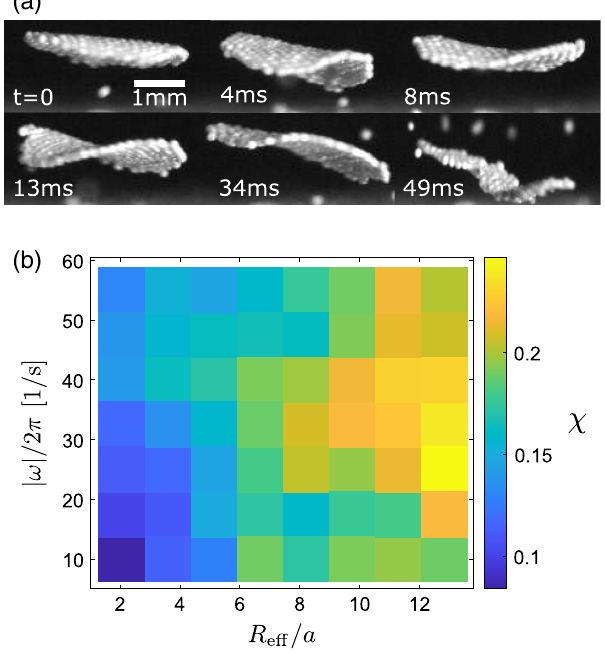
FIG. 10. Rotation activating out-of-plane bending in levitated granular rafts. (a) Sequence of side-view images showing the rotation of a raft, which eventually elongates into an ellipse ( t ¼ 34 ms). During the process of spinning up, the raft deforms significantly out of plane. (b) Raft concavity χ (value shown by the color bar, see text for definition), as a function of the absolute =a . The data represent rotational frequency j ω j and raft radius R eff observations of 60 (independently self-assembled) rafts. The 95% confidence intervals for χ are approximately constant as a =a and do not exceed 0.02 for any function of j ω j and R eff